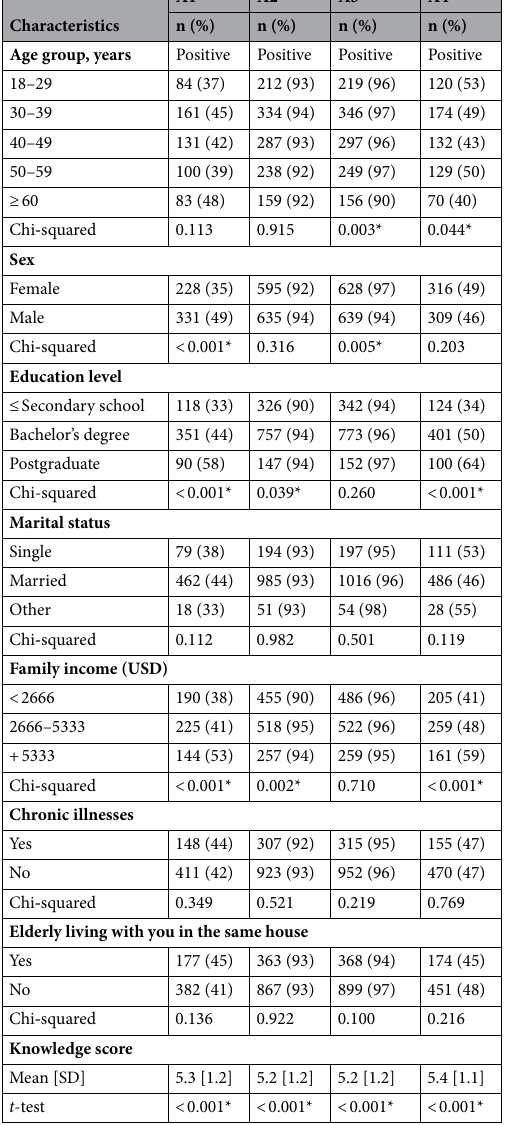
Table 4. Attitudes to handwashing based on sociodemographic variables. Knowledge score (negative attitude, mean [ SD ] for A1 = 5.01 [1.2], A2 = 4.5 [1.3], A3 = 4.6 [1.3], A4 = 4.9 [1.2]). *p <